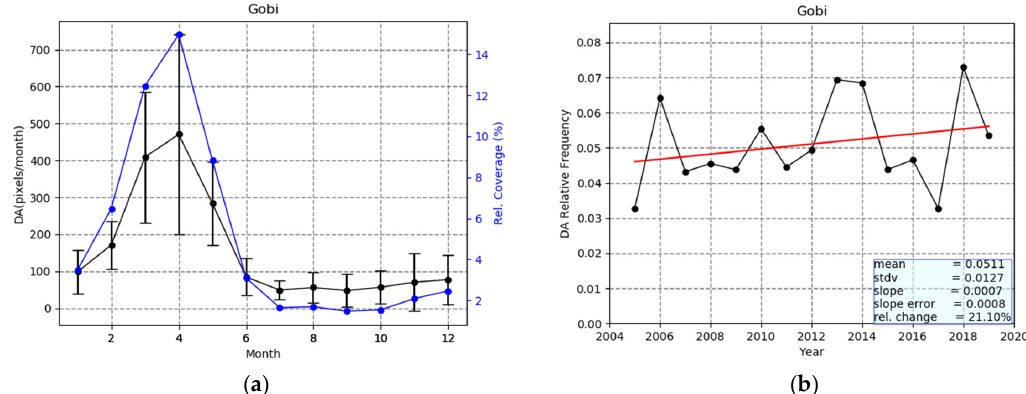
Figure 14. ( a ) Intra-annual variability of the 2005–2019 averages of the total absolute number of grid cells (1° × 1°) where dust aerosols (DA) have been detected over the Gobi by the satellite algorithm (left axis) and the percent coverage of the region by dusty grid cells (right axis). The error bars represent the year-by-year variability by means of computed 2005–2019 standard deviations. ( b ) Inter-annual variability and linear trend of the relative frequency of dust aerosols (DA) over Gobi.